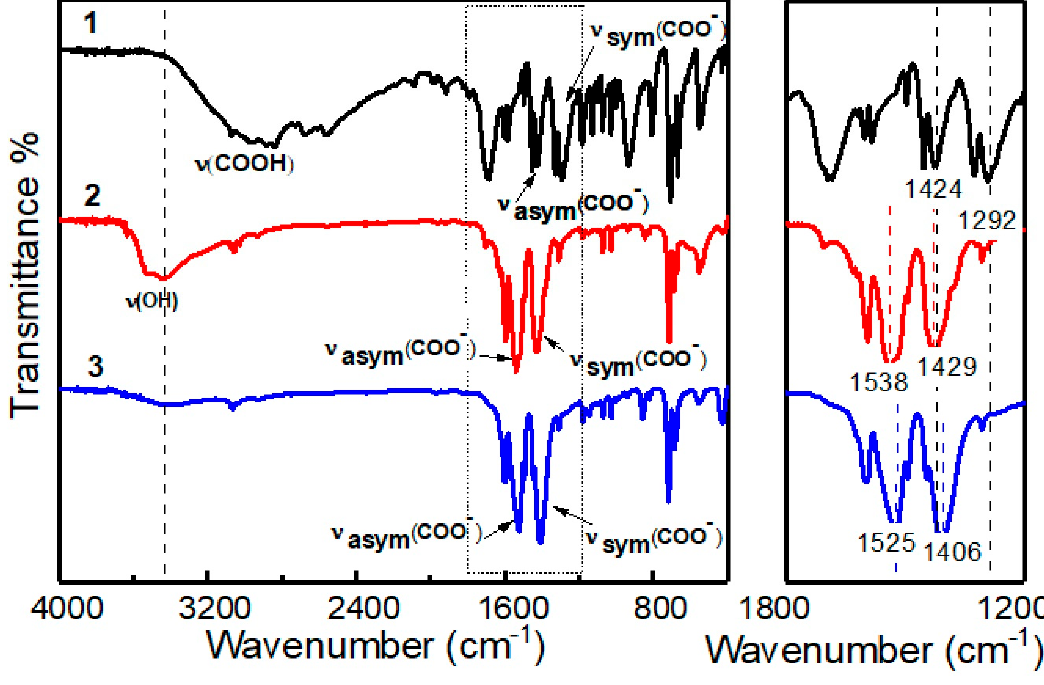
Figure 3. FTIR spectroscopy for 1 : benzoic acid; 2 : [Eu(OOCC 6 H 5 ) 3 · (H 2 O) 3 ]; 3 : [Eu(OOCC 6 H 5 ) 3 · (HOOCC 6 H 5 ) 2 ] .